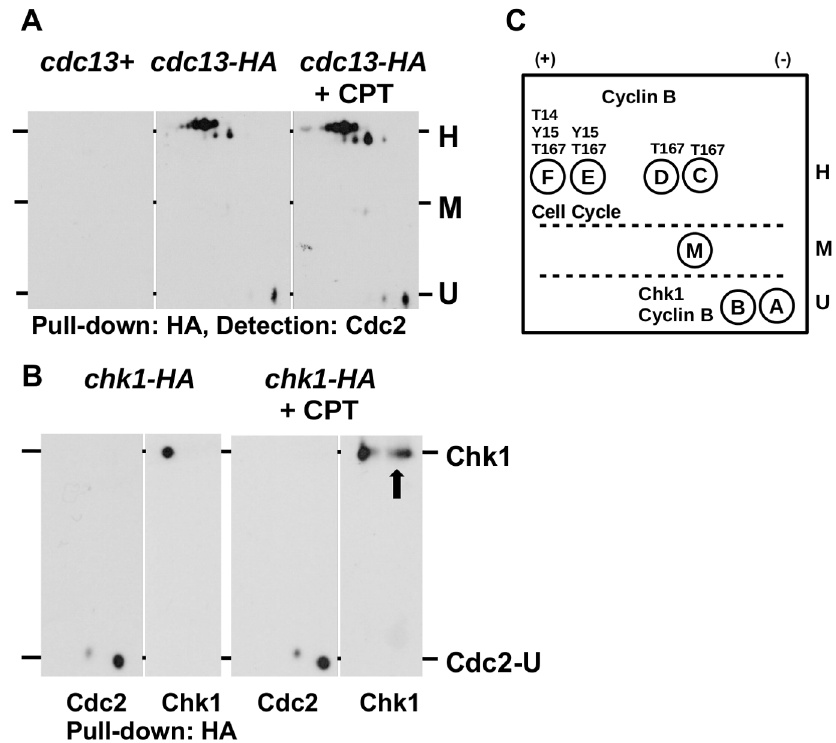
Fig 4. Unphosphorylated Cdc2 associates with Chk1 kinase. (A) Cyclin B (Cdc13) was immunoprecipitated from untreated and CPT-treated (40 μ M CPT, 4h) cdc13-HA cells and the precipitated protein was detected with the anti-Cdc2 antibody. Wild type ( cdc13+ ) cells were included as a negative control. (B) The DNA damage checkpoint kinase Chk1 was immunoprecipitated from untreated and CPT- treated (40 μ M CPT, 4h) chk1-HA cells and the precipitated protein was detected with the anti-Cdc2 antibody and an anti-HA antibody (Chk1). The arrow indicates the DNA damage-induced phosphorylation of Chk1. Cdc2-U indicates the unphosphorylated Cdc2 species Ua and Ub. (C) Model. Since all four forms (C-F) in the H range bind to cyclin B (Cdc13) they are likely to be T167 phosphorylated. Cdc2-Hf may carry phosphate residues at T14, Y15 and T157, whereas Cdc2-He may be only phosphorylated at Y15 and T167. Cdc2-He and Cdc2-Hf are both involved in cell cycle regulation. Cdc2-Hc and Cdc2-Hd associate with cyclin B and may therefore be T167 modified. The unphosphorylated forms Cdc2-Ua and Cdc2-Ub associate with Chk1 and Cyclin B and may act in the response to DNA damage. Cdc2-M may be serine